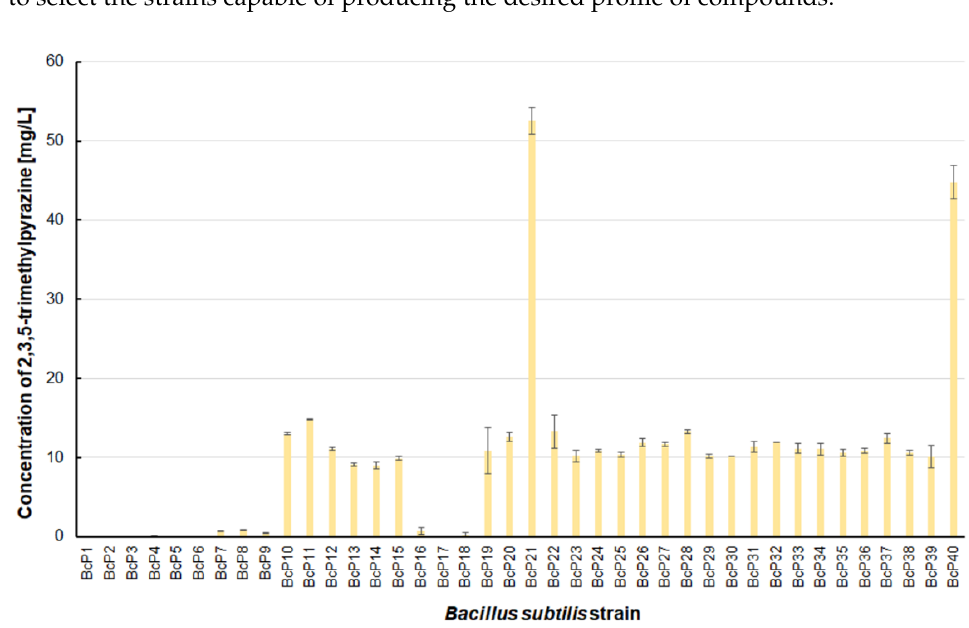
Figure 8. The 2,3,5,6-tetramethylpyrazine biosynthesis by B. subtilis strains. The BcP21 strain was the best producer of pyrazines (in total) of all the strains se- lected from fermented soybeans, producing these compounds at a total concentration of approximately ca. 560 mg/L (Table 1). The second most effective strain was BcP40, capable of producing pyrazines at a level of 320 mg/L. None of the other analyzed strains pro- duced pyrazines in concentrations greater than 100 mg/L (Table 1). The dominant com- pound among the produced pyrazines was 2,3,5,6-tetramethylpyrazine. When analyzing the results of screening tests, one should also consider the profile of the obtained pyrazine